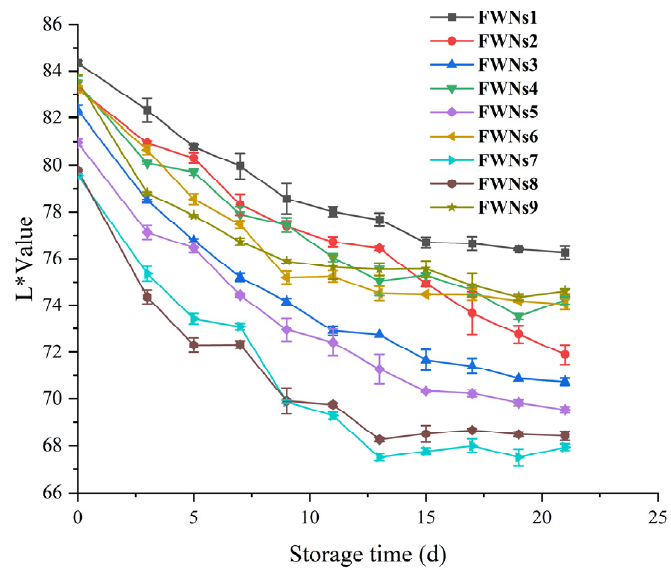
Figure 3. L* value changes of FWNs1 − FWNs9 during storage at 4 ◦ C. The L* values of all samples showed a downward trend during the whole storage. The value of L* decreased rapidly in the early stage (0 − 5 d). After storage at 4 ◦ C for 5 days,